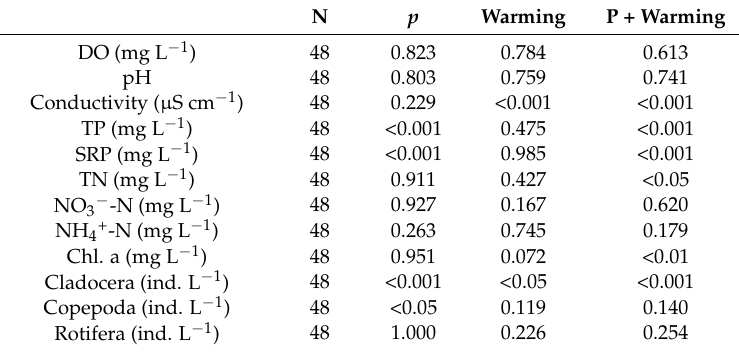
Table 2. Summary of ANOVA tests (one-way analysis of variance, repeated measures) and analysis of the effect of phosphorus addition and warming on water chemistry, chlorophyll-a, and zooplankton abundance.